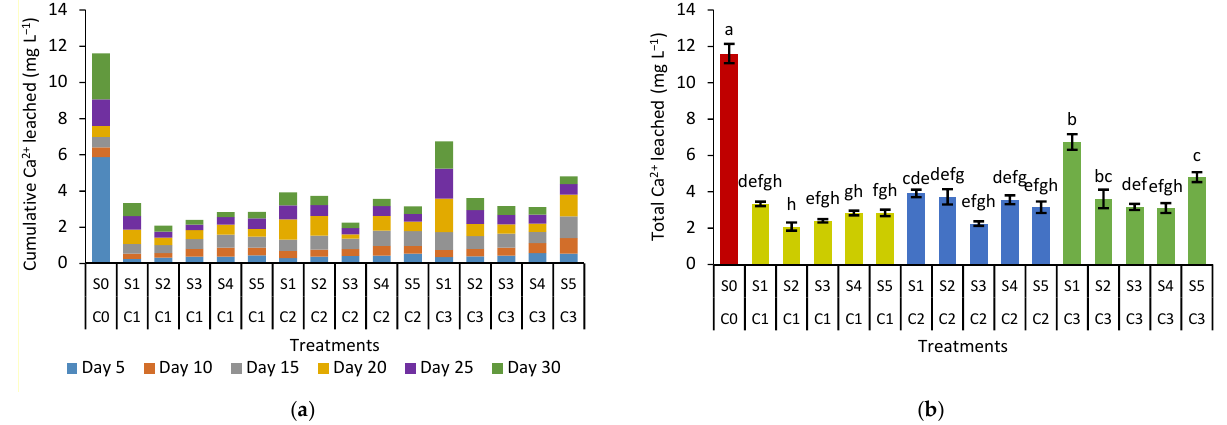
Figure 9. ( a ) Cumulative calcium in leachates at five day intervals and ( b ) total calcium in leachates for the different treatments after thirty days of leaching. Different letters indicate significant mean differences using Tukey’s HSD test at p ≤ 0.05. Error bars represent the standard error of the mean.